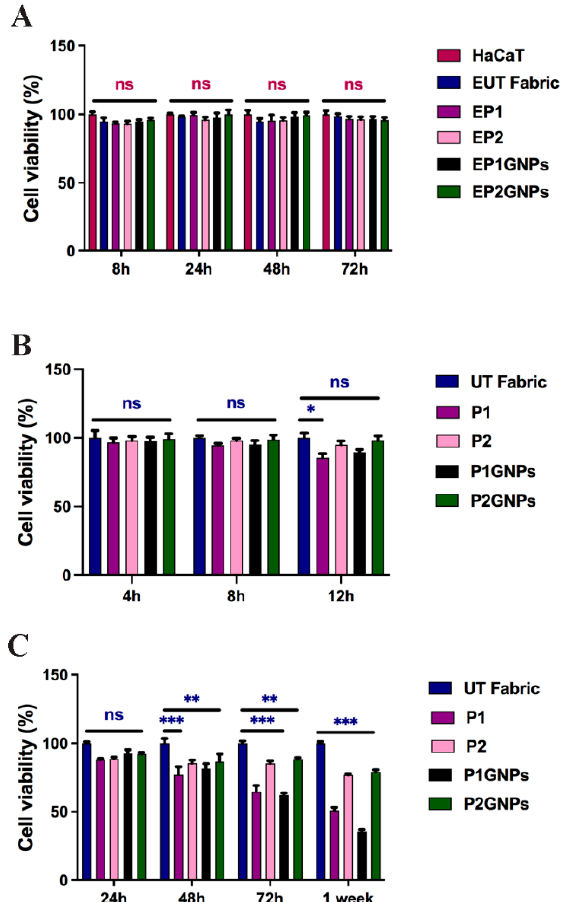
Figure 3. Cell viability evaluated by MTT assay of HaCaT cells grown: ( A ) in the presence of fabric extracts at 8, 24, 48 and 72 h; ( B ) in direct contact with smart fabrics at 4, 8 and 12 h; ( C ) directly on smart fabrics for 24, 48, 72 h and 1 week. The data are normalized to: ( A ) untreated HaCaT cells; ( B ) HaCaT cells grown in direct contact with untreated fabric; ( C ) HaCaT cells grown on untreated fabric (UT) and reported as a percentage. Statistical analysis was performed by the two-way analysis of variance (ANOVA) method coupled with the Bonferroni post-test. (* p < 0.05; ** p < 0.01; *** p < 0.001; ns: not significant).